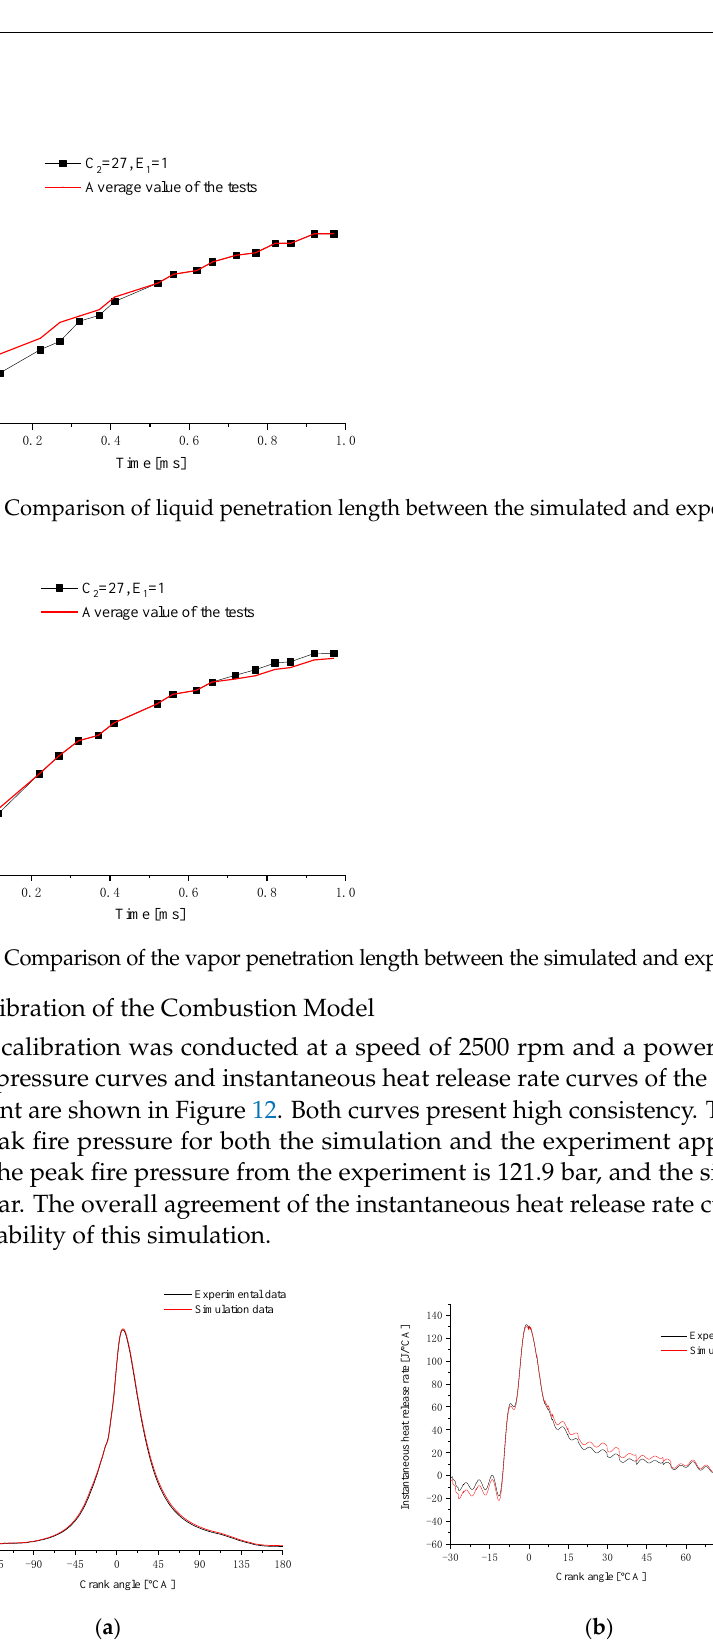
Figure 12. Comparison of in-cylinder pressure and Instantaneous heat release rate between the simulation and experiment. ( a ) Cylinder pressure; ( b ) Instantaneous heat release rate.